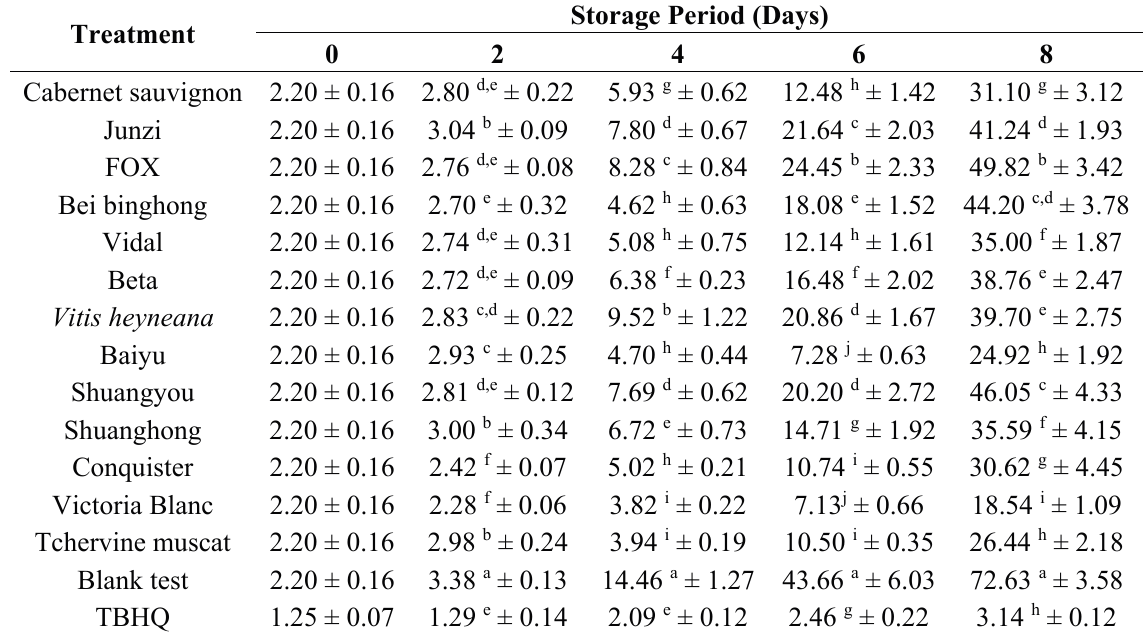
Table 4. POV (meqO 2 /kg sample) of edible oils samples treated with TBHQ and grape polyphenol extracts from canes with ethyl acetate antioxidation test at 70 ± 1 °C, kept in the